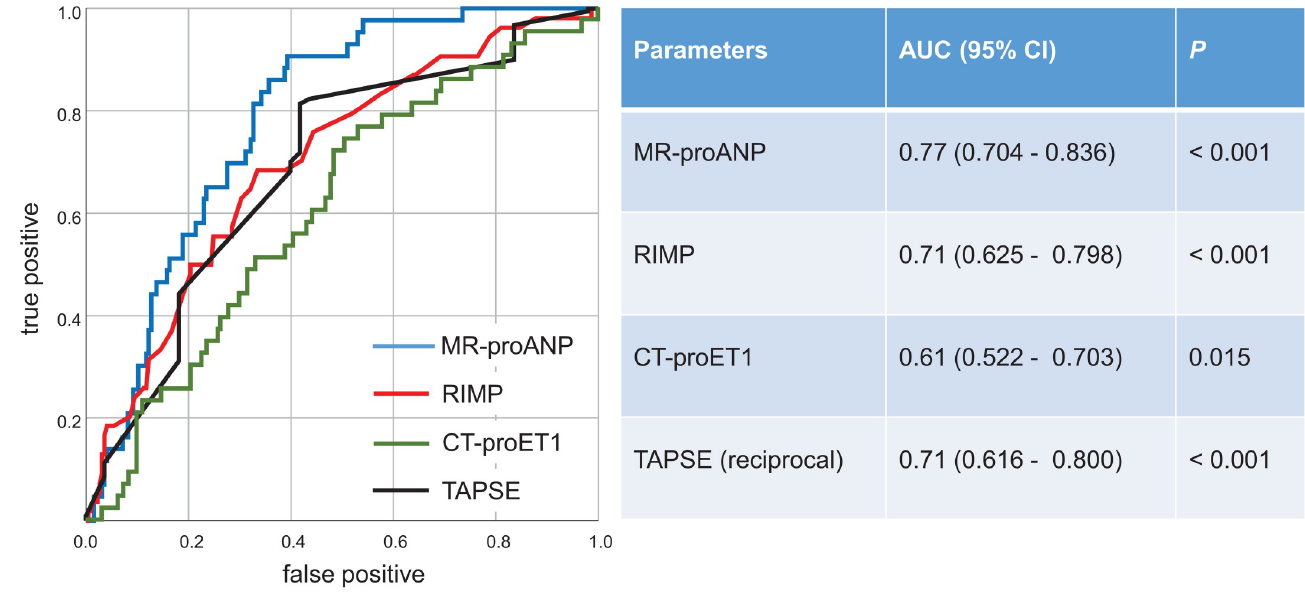
Fig 3. Receiver operating characteristic curves for predicting BPD/death in preterm infants < 32 weeks of gestation.